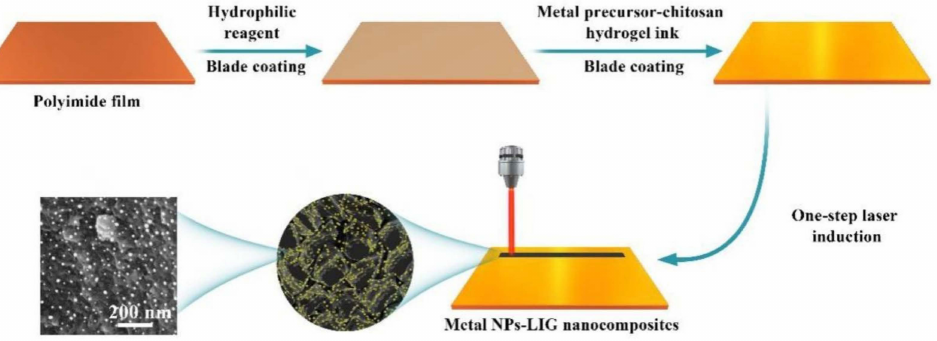
Figure 5. Schematic illustration of the formation process of metal nanoparticle–LIG hybrid nanocom- posites using the one-step laser induction method [35]. Copyright Elsevier,